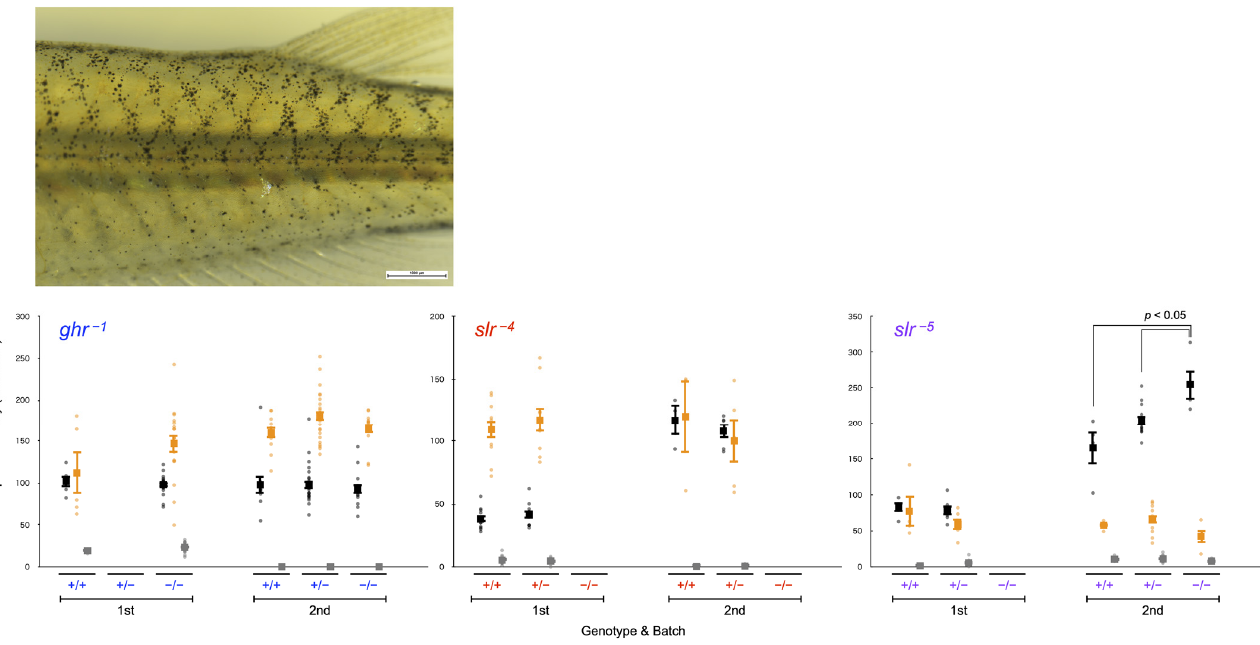
Figure 6. Comparison of body color. ( a ) Example of the images used for counting chromatophores. ( b ) Chromatophore densities in adult medaka. The numbers of melanophores (black dots), xanthophores (orange dots), and leucophores (gray dots) in ghr − 1 , slr − 4 , and slr − 5 adult fish examined twice in two different batches are shown. Genotypes are indicated as +/+ (WT fish), +/ − (heterozygotes), and − / − (homozygotes). A dot represents the chromatophore density of each individual and a closed box with bars indicates the mean and standard error.